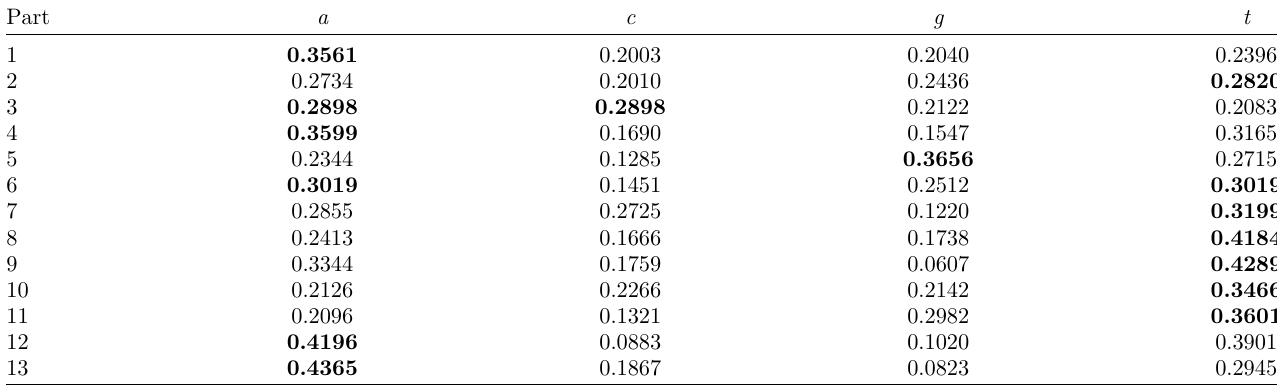
^ Table 8. P ( (cid:5) | I i ), i = 1, ... , 13, for the model – (ii) with o = 3 and G = 9, see Table 6. In bold the highest probabilities by part.